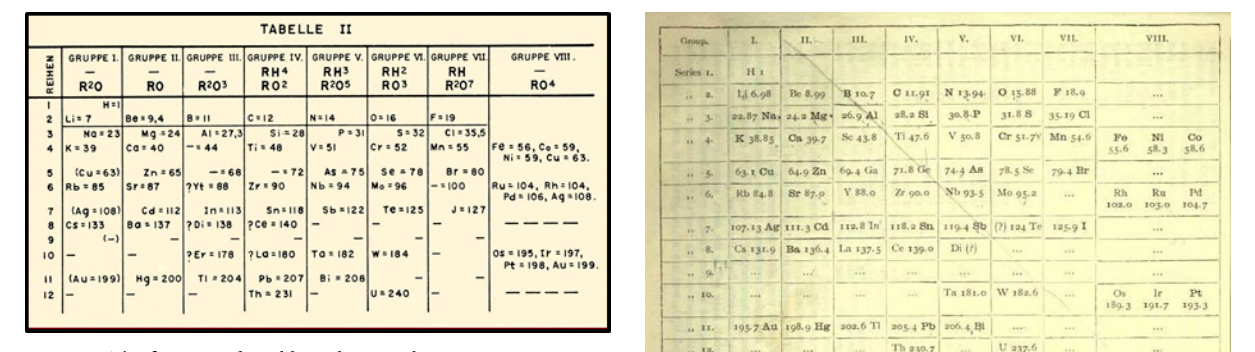
Figure 7. The first periodic table with vertical groups.